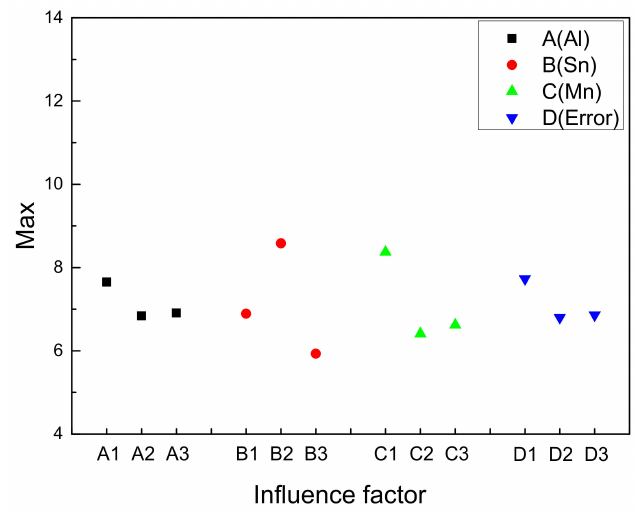
Figure 9. Factors and Index trends diagram of maximum texture intensity for nine trial samples.